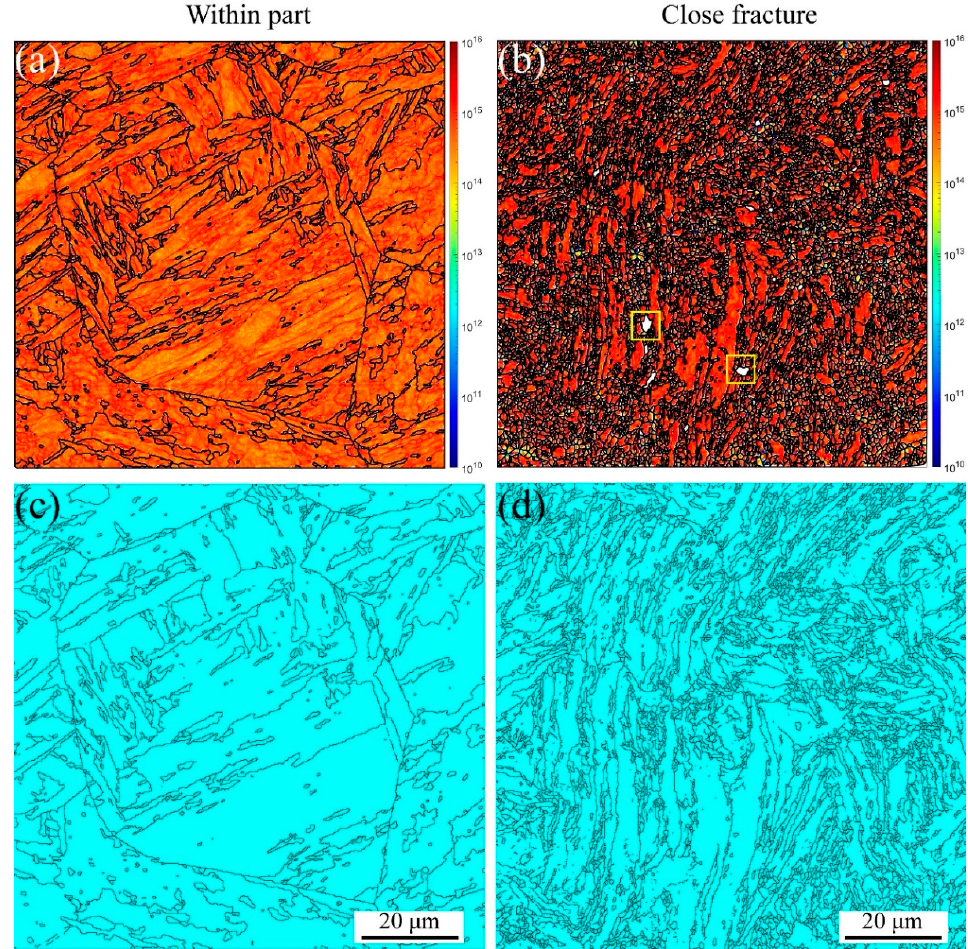
Figure 10. GND and twinning maps under different strain gradients at the strain rate of 5 × 10 − 5 s − 1 under RT (Voids are inside the yellow square). ( a , b ) GNDs and ( c , d ) twinnings. Figure 11 shows the EBSD results at a strain rate of 5 × 10 − 5 s − 1 under 430 °C. The stable and unstable PAGBs and martensite laths are observed within part and close fracture, respectively, as shown in Figure 11a–d. The internal defects, i.e., voids indicated with the red arrows, shrinkage microstructure defined with the green arrows, and cracks across the voids and shrinkage marked with the yellow arrows, are observed along with the dis- torted and elongated microstructure. The misorientation angles presented in Figure 11e,f are the same as the results under RT. However, it should be emphasized that this results from the combined influence of temperature and strain rate. In Figure 11g,h, the material orientation becomes uniform after high plastic strain during the uniaxial tensile process under 430 °C for MarBN. After high plastic strain, the texture is also present only in the <101>//Z 0 direction, and the strength of the texture is enhanced compared to the low strain state.